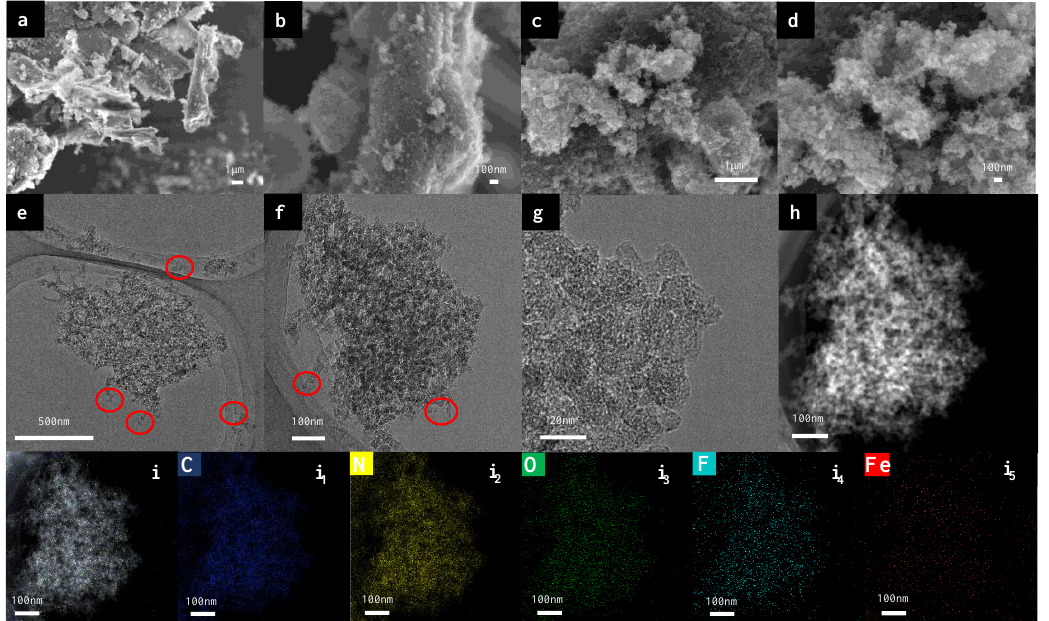
Figure 3. ( a , b ) SEM image of 2 1 P 2 -850. ( c , d ), SEM image of 2 1 P 2 -Fe 1 -850. ( e – g ) TEM images, ( i ) STEM images, and ( i ), ( i 1 – i 5 ) EDS elemental mapping of C, N, O, F, and Fe. Scale bars: ( a , c ) 1 μm, ( e ) 500 nm, ( g ) 20 nm, ( b , d , f , h , i , i 1 – i 5 ) 100 nm. The transmission electron microscopy (TEM) images of 2 1 P 2 -Fe 1 -850 (Figure 3e–g ellipse markers). The scanning transmission electron microscopy (STEM) image (Figure